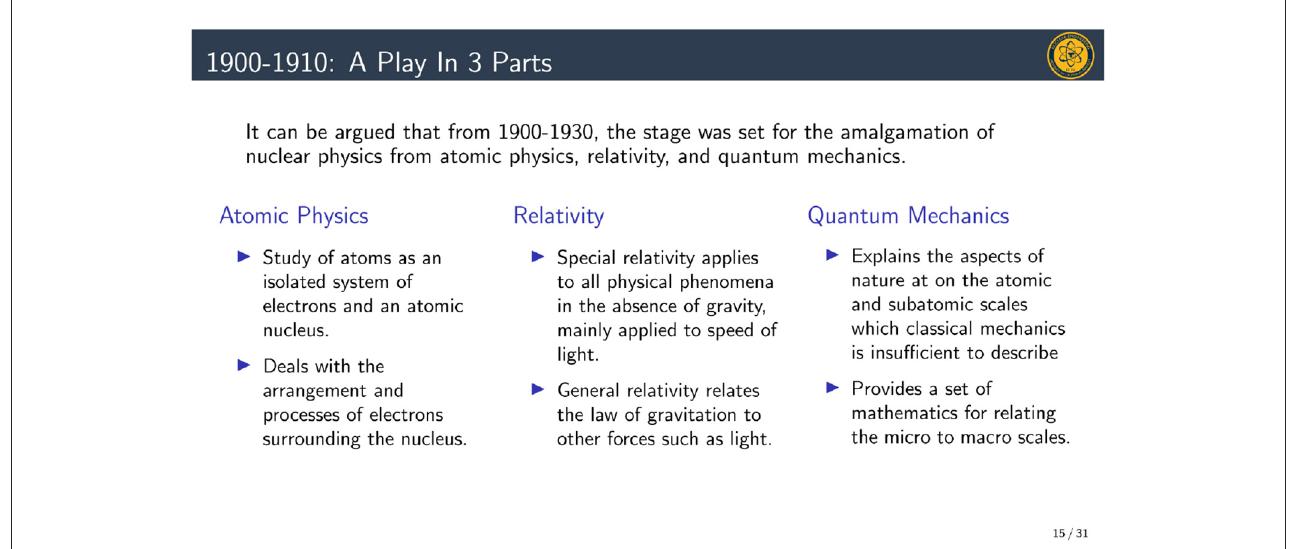
FIGURE2 A play in two parts. Lecture